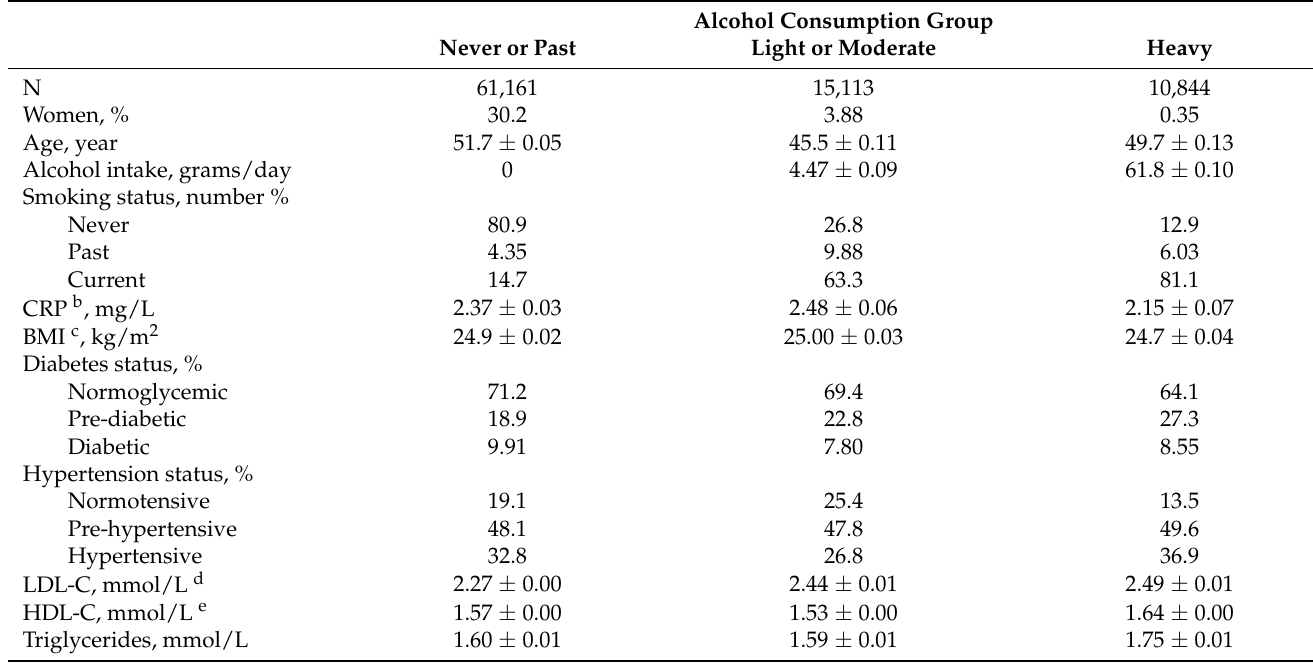
Table 1. Baseline characteristics in 2006 by alcohol consumption group among 87,118 Kailuan participants without rheumatoid arthritis, adjusted for age and sex a